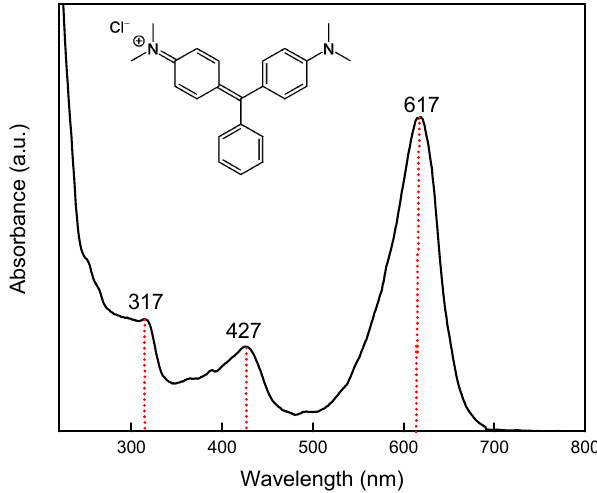
Figure 9. Absorbance spectrum of malachite green dye.